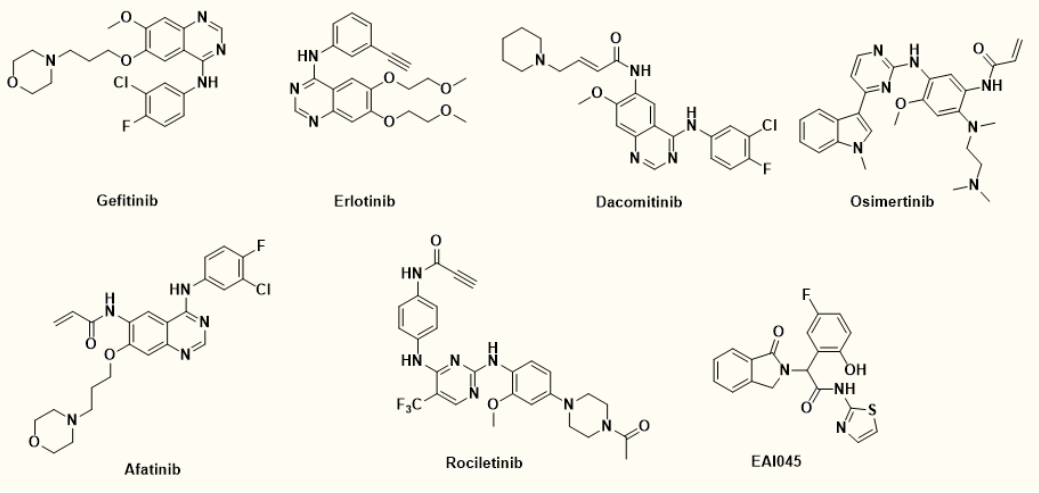
Figure 1. Chemical structures of FDA-approved epidermal growth factor receptor (EGFR) inhibitors.